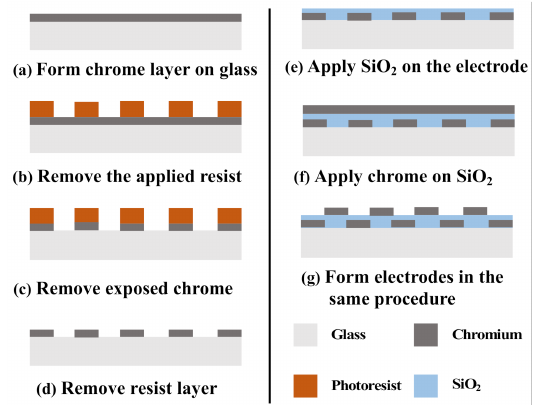
Figure 4. Fabrication process of the proposed tactile